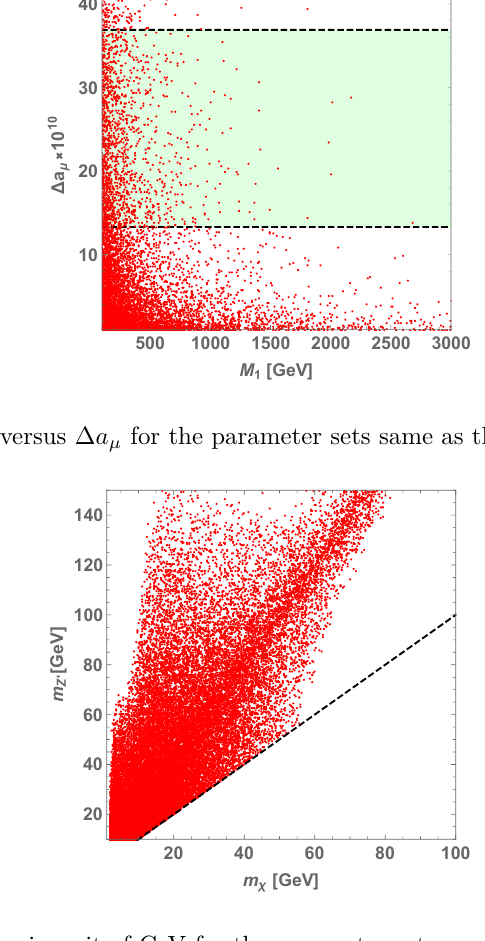
Figure 5 . m χ versus m Z 0 in unit of GeV for the parameter sets same as the previous plots. The ‘ dashed line corresponds to m χ = m Z 0